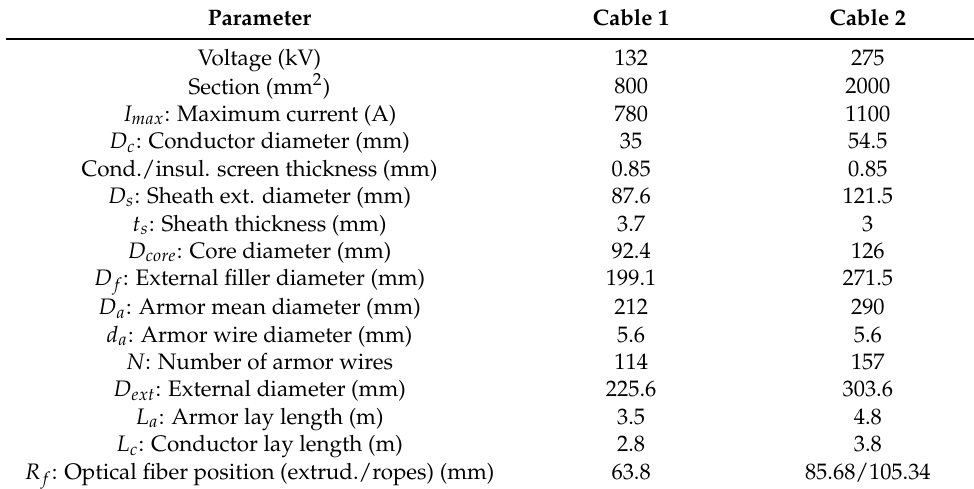
Table 1. Main dimensions of Cables 1 and 2 (Figure 6).